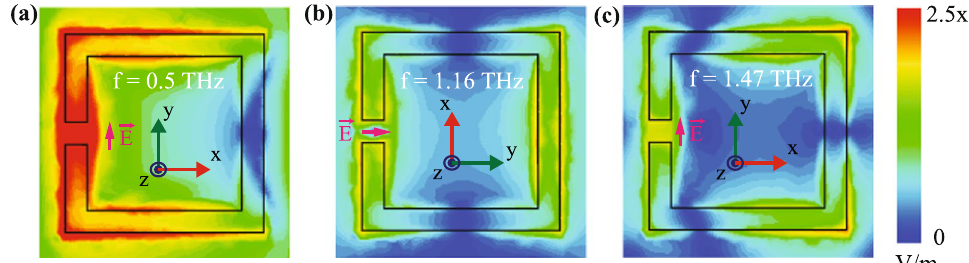
Figure 5. ( a ),( b ) and ( c ) represent the Electric field profiles of 1 st , 2 nd and 3 rd resonances at 0.5 THz, 1.16 THz and 1.47 THz, respectively. The green colored y-axis signifies the polarization direction of the incident electric filed.